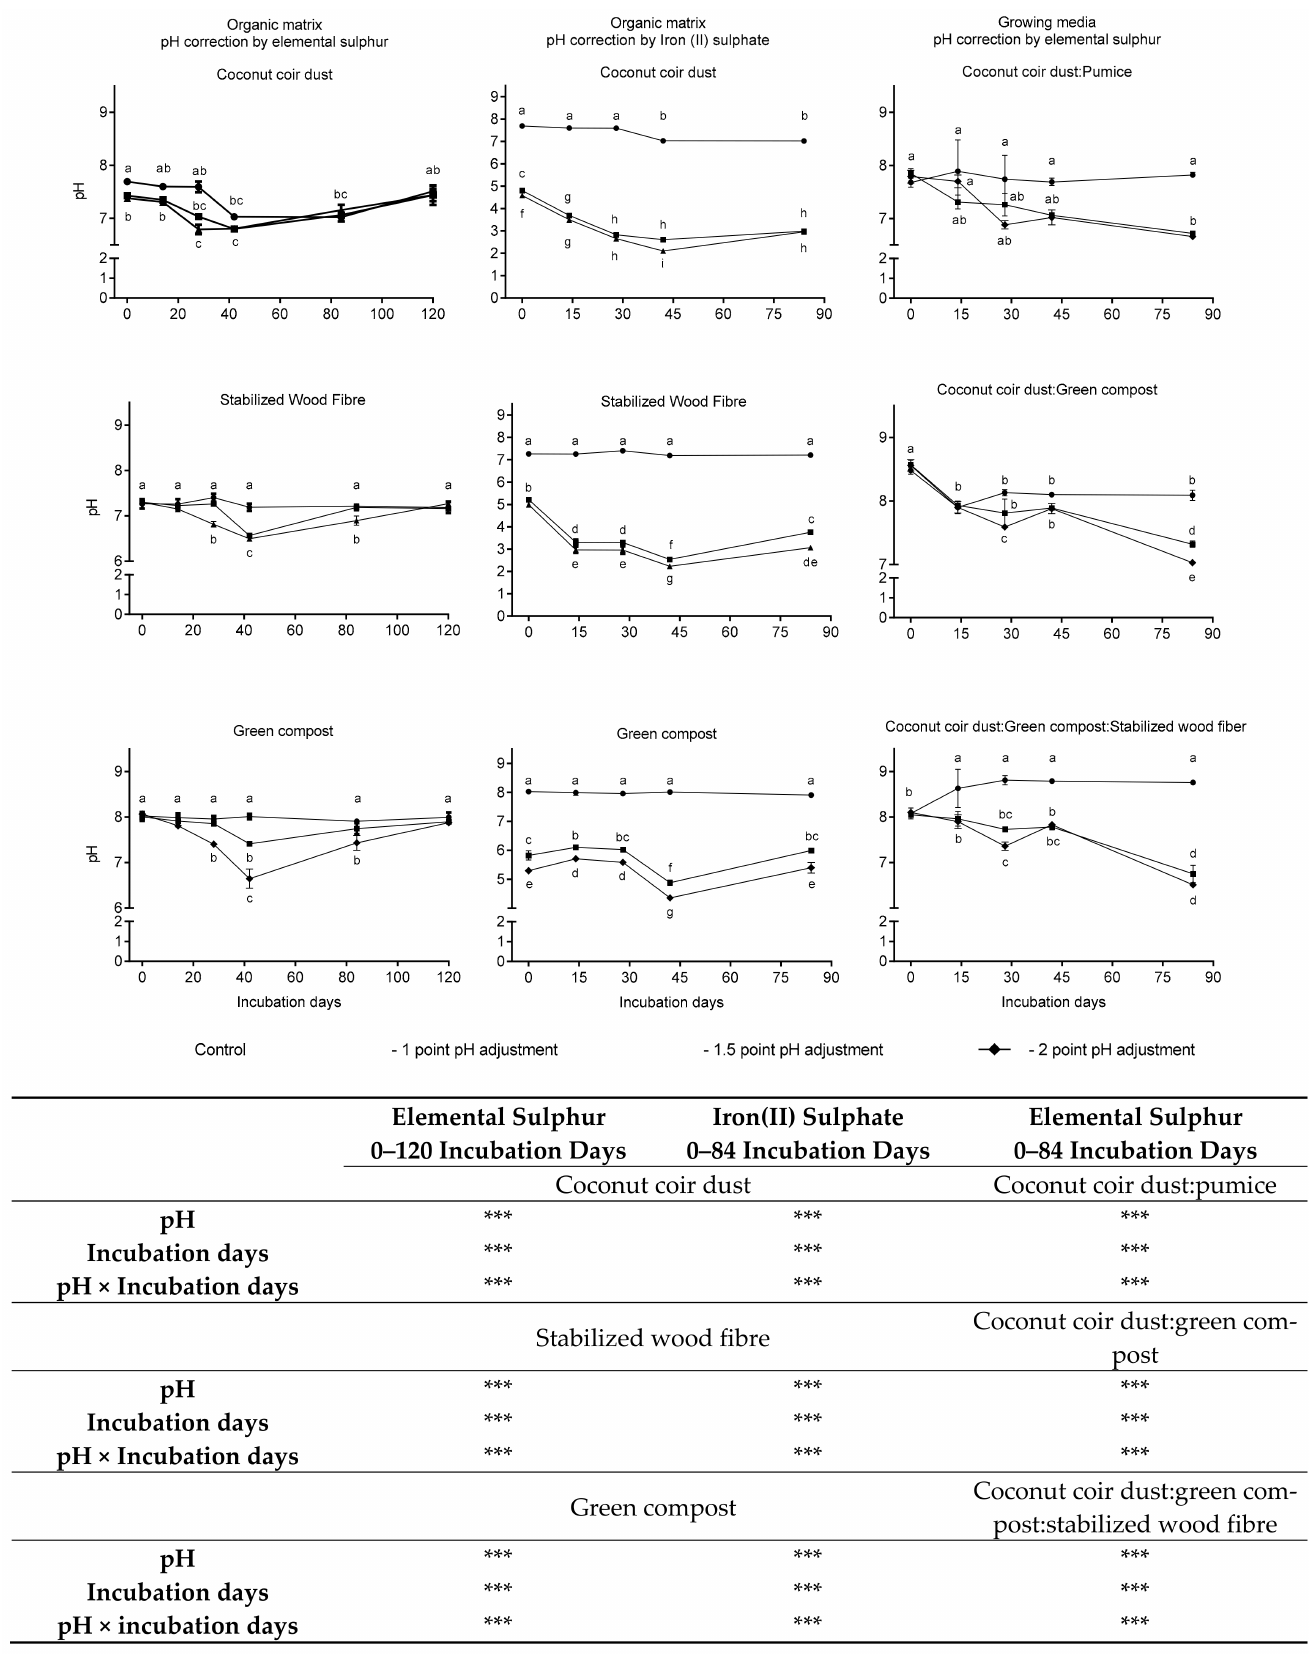
Figure 2. pH trend of the different matrices (coconut coir dust, stabilized wood fibre, and green compost) and of the tested growing media during the incubation tests (i.e., climatic chamber) at constant temperature (21 ◦ C) with elemental